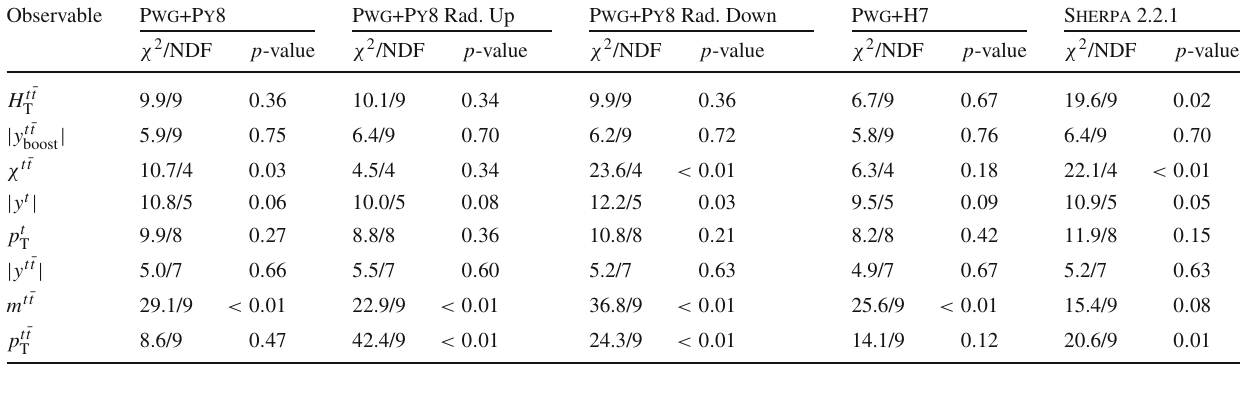
Table 18 Comparison of the measured parton-level absolute single- differential cross-sections in the resolved topology with the predictions from several MC generators. For each prediction a χ 2 and a p -value are